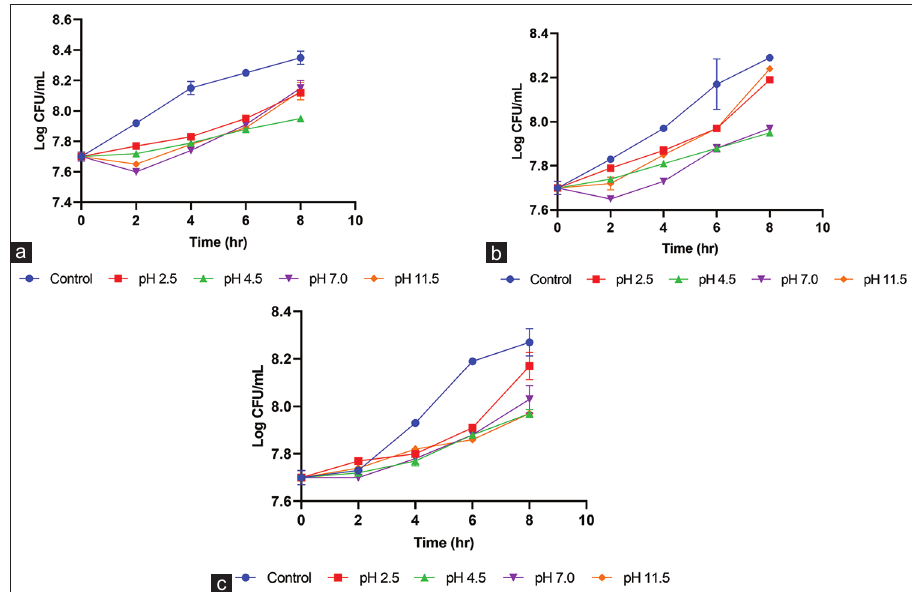
Figure-2: Time-kill measurements of ionized waters of different pH on Gram-negative bacterial isolated from horses wound. (a) Escherichia coli , (b) Pantoea agglomerans , and (c) Klebsiella pneumoniae .